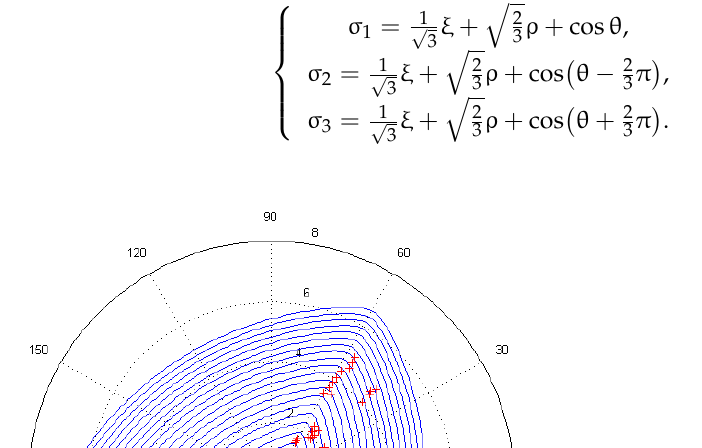
Figure 20. The experimental fitting on the yield surface curve in the deviatoric plane.